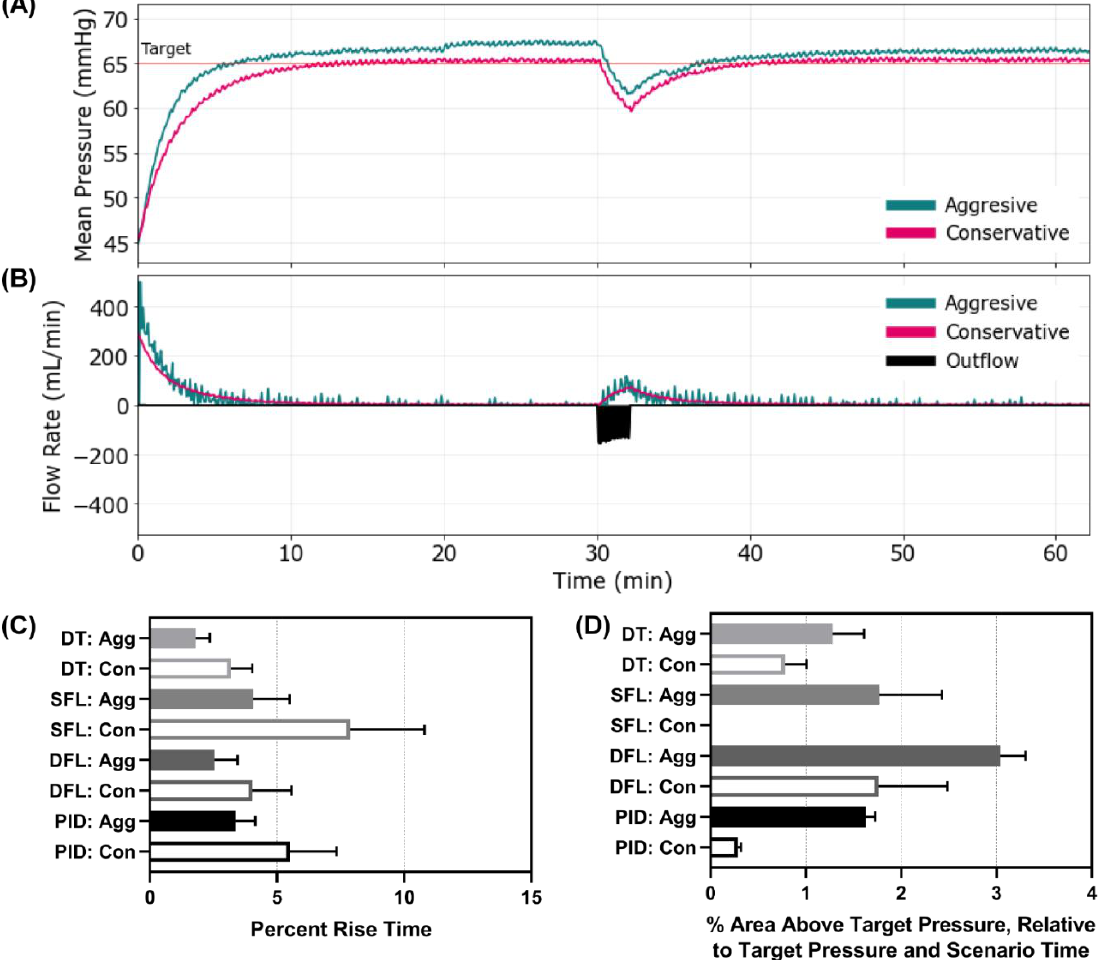
Figure 3. Controller performance for Scenario 1. Representative ( A ) MAP and ( B ) inflow/outflow vs. time for a single run of the aggressive and conservative PID controllers through Scenario 1. Outflow rates are only shown for one controller run. In Scenario 1, MAP begins at 45 mmHg with no active hemorrhage until at 30 min when a severe hemorrhage occurs for 2 min, followed by a return to no hemorrhage. Performance results for each controller type (DT = decision table; SFL = single- input fuzzy logic; DFL = dual-input fuzzy logic; PID = proportional – integral – derivative controller) and configuration (Agg = aggressive; Con = conservative) for the ( C ) percent rise time (lower is better) and ( D ) area above the target pressure metric (lower is better). Average results are shown for three subject variability runs for each. Error bars denote the standard deviation. 3.2. Scenario 2 Controller Performance Next, Scenario 2 involved an active hemorrhage that reduced its rate with time and an initial MAP of 65 mmHg — simulating a re-bleed event after initial stabilization. MAP and inflow/outflow vs. time plots are shown for the aggressive and conservative configu- rations of the SFL controller (Figure 4A, B). Plots for the remaining controller types and configurations are provided in Supplementary Figure S2. With an active hemorrhage, the scenario resulted in more dynamic pump rates, with infusion rate variability being as high as 167% for the aggressive DT (Figure 4C). Interestingly, the conservative DT also had higher infusion rate variability than other controller types, indicating that the DT logic had inherently high scores for this metric, within this scenario. Each controller responded quickly to prevent large drops in MAP for this scenario, but the aggressive configuration continued to do so more quickly (Supplementary Figure S2). As a result, the area below the target pressure was minor for all controllers, with both DT configurations and DFL